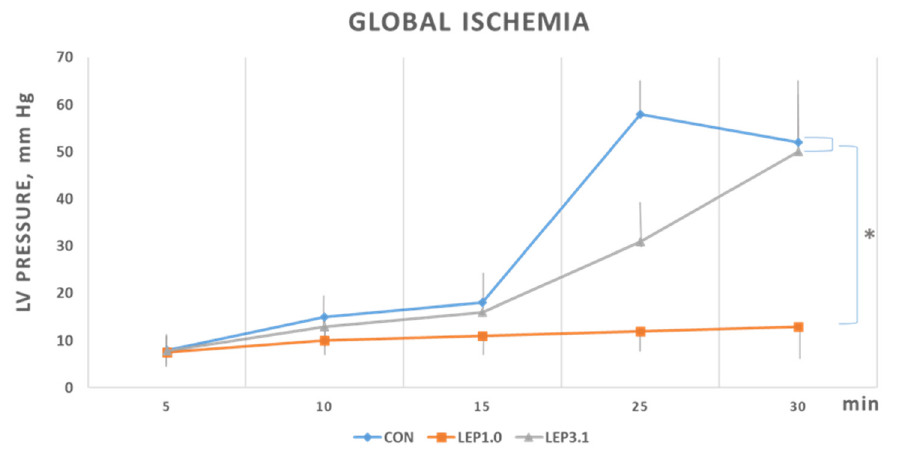
Figure 3. Ischemic contracture in the control (CON), leptin 1.0 nM (LEP1.0), and leptin 3.1 nM (LEP3.1) groups. Data are presented as mean ± standard deviation. * p < 0.0001.